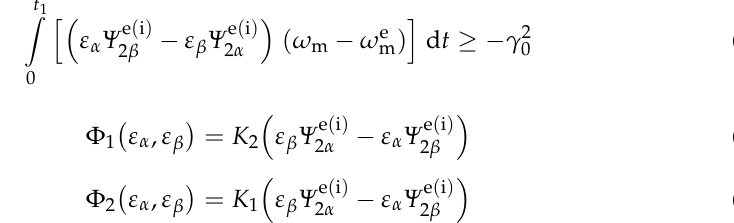
Figure 2. The schematic diagram of the MRAS (u-i) .